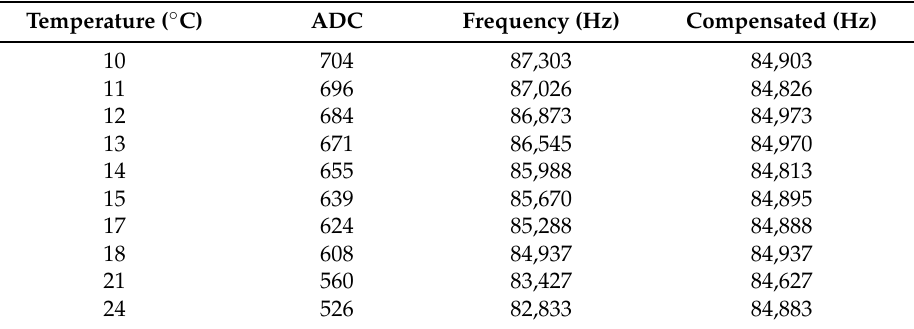
Table 2. Compensated results from readings in Table 1.